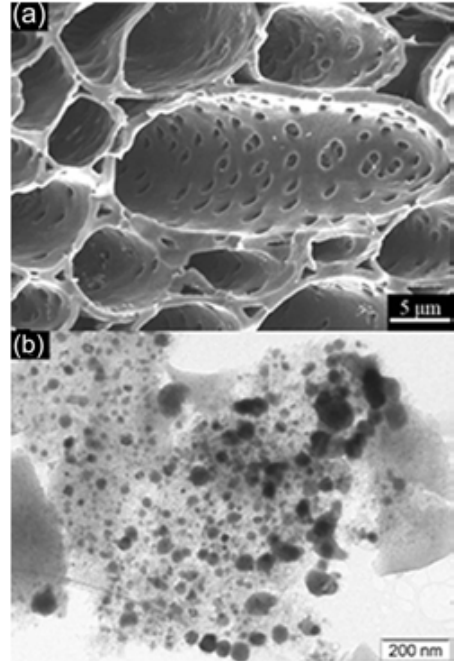
Fig. 6 SEM and TEM images of C(Co) nanocompos- ites (a. SEM